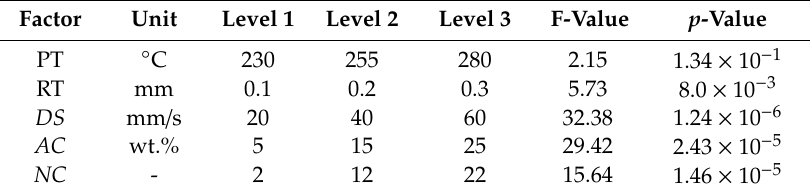
Table 7. ANOVA results for ULSF for ABS BM FDM.